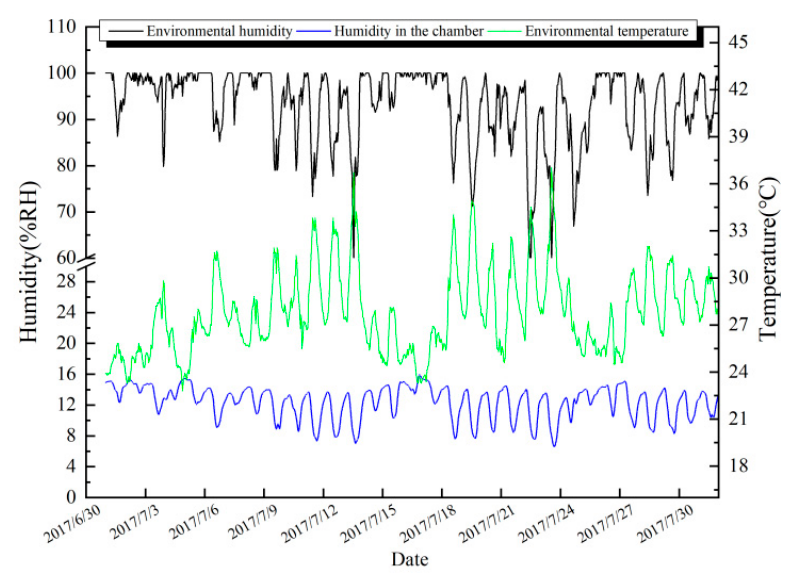
Figure 4. One month’s comparison result of humidity in environment and in the chamber. It can be observed that the temperature and relative humidity of the location envi- ronment vary are in the ranges of 22.8 ◦ C~37.0 ◦ C and 55.0%RH~100%RH, respectively. Inside the collection chamber, the relative humidity of sampling air is greatly reduced, which is varied in a limited range from 6.6%RH to 15.9%RH. More than 80% water